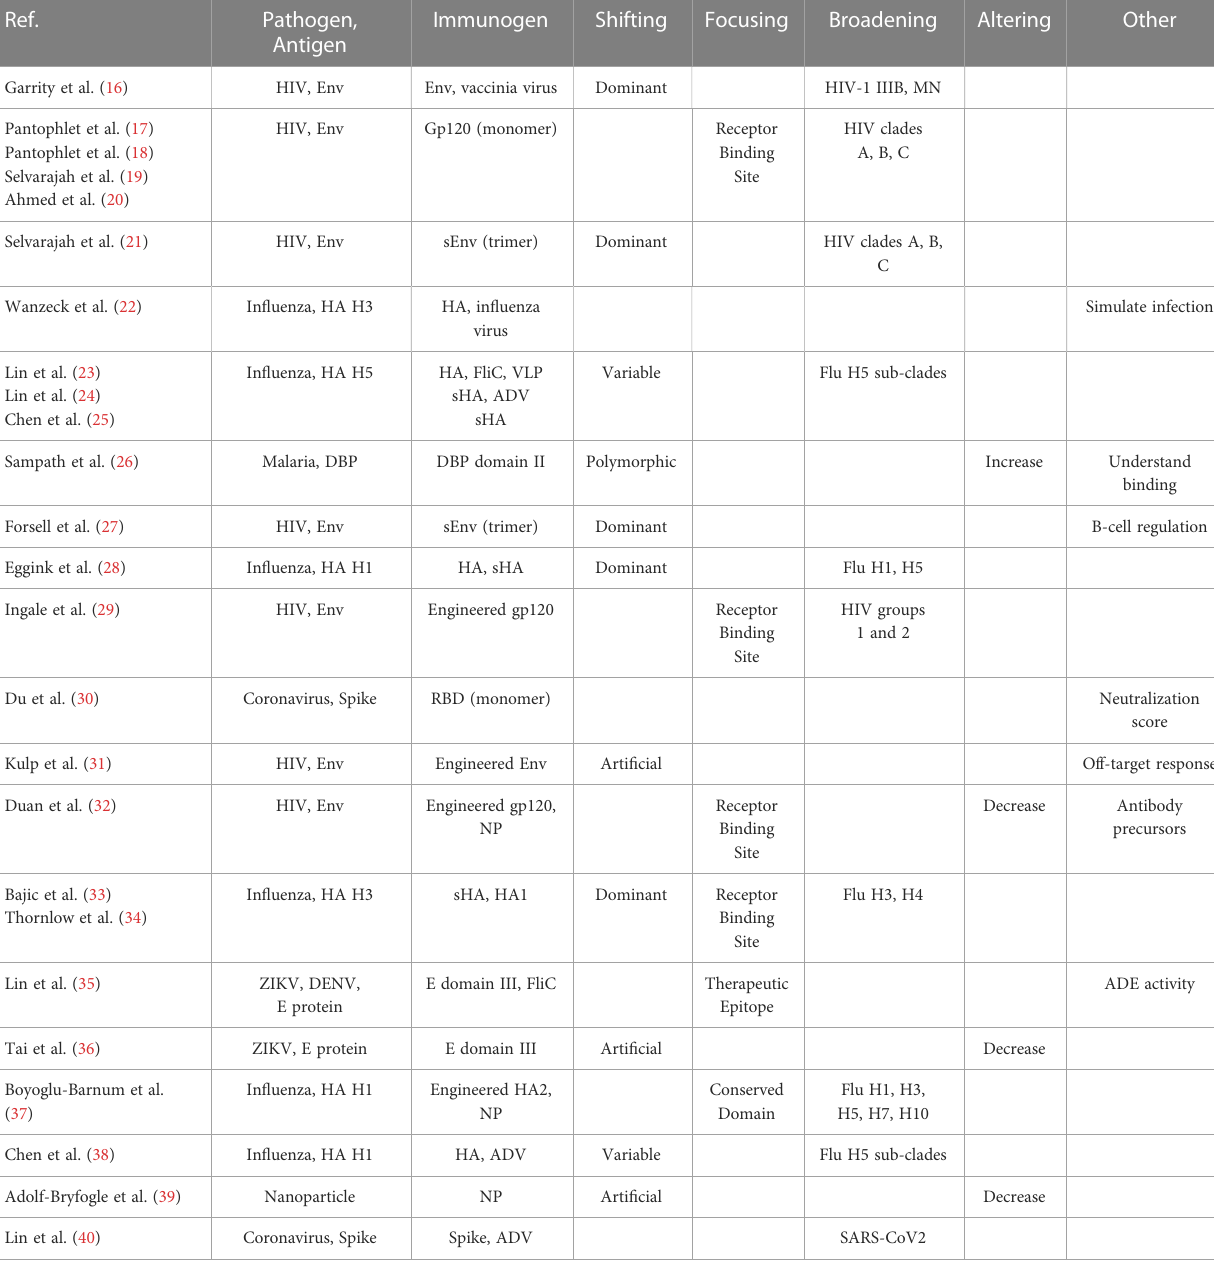
TABLE 1 Collection of articles on vaccine design through glycan masking.